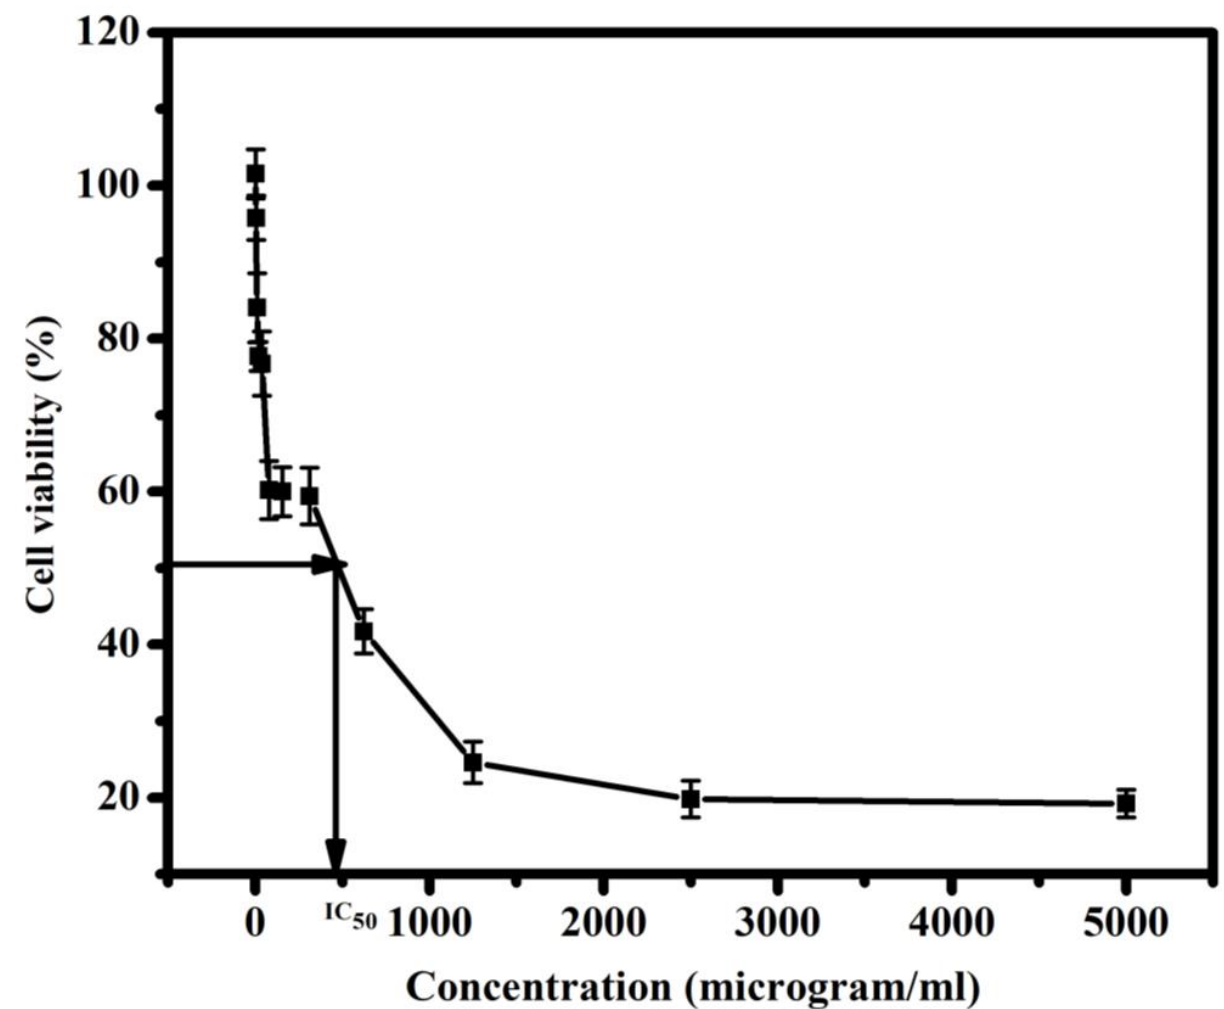
Figure 6. Cell viability of Mg 3 (VO 4 ) 2 /MgO/GO@CA, using normal lung cell line.